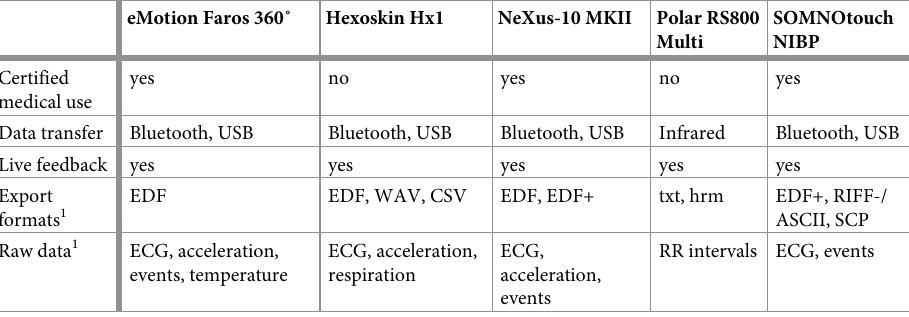
Table 2. Special technical information for scientific